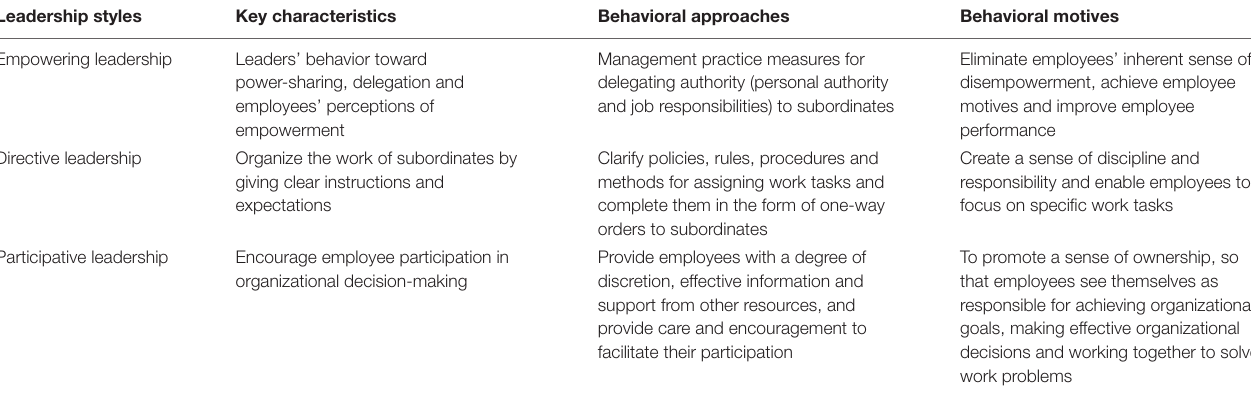
TABLE 2 | Contrast of different leadership